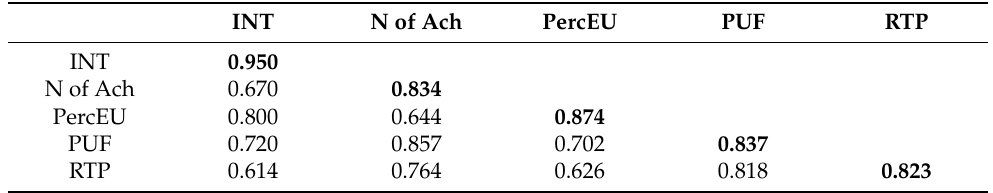
Table 4. The Fornell–Larcker criterion.